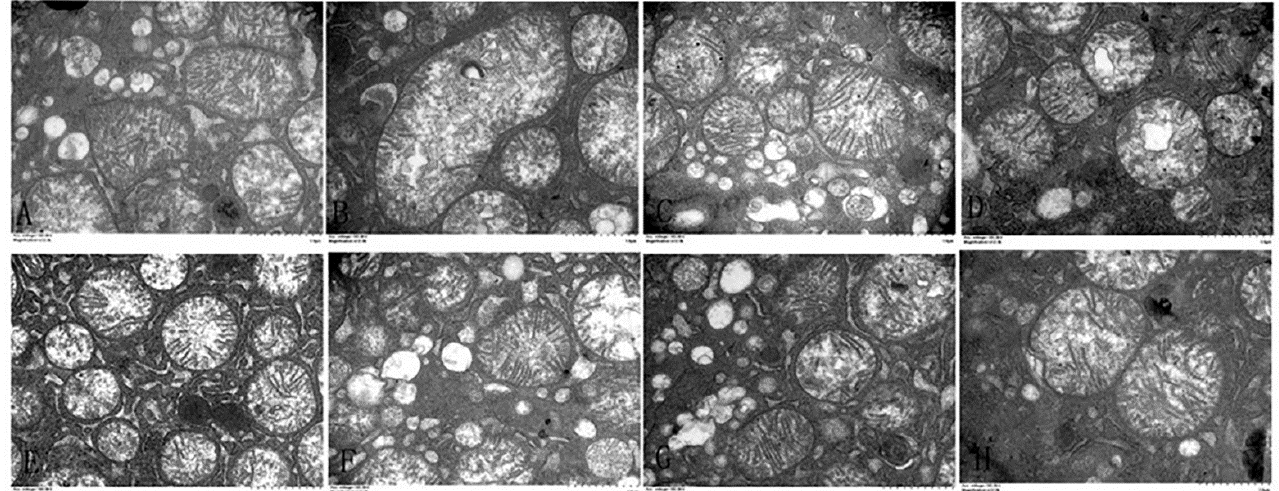
Figure 5. The effect of α -lipoic acid and chlorogenic acid on mitochondria of cadmium-exposed chicken liver (12,000×). ( A ): Control group, ( B ): Cd group, ( C ): α -LA group, ( D ): CGA group, ( E ): α -LA + CGA group, ( F ): Cd + α -LA group, ( G ): Cd + CGA group and ( H ): Cd + α -LA + CGA group.